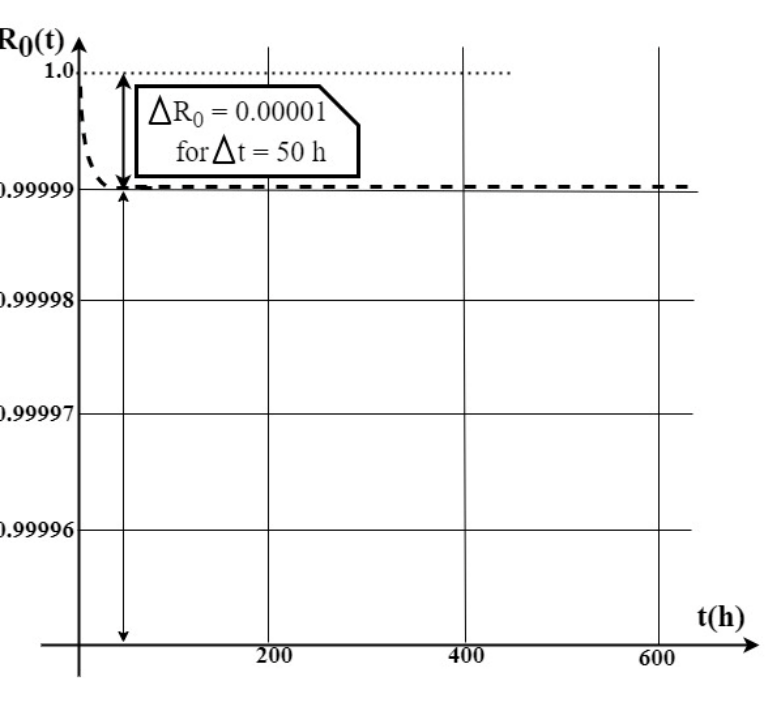
Figure 7. Waveform of the probability function R 0 ( t ) related to electronic security system power supply devices staying in a state of full fitness.